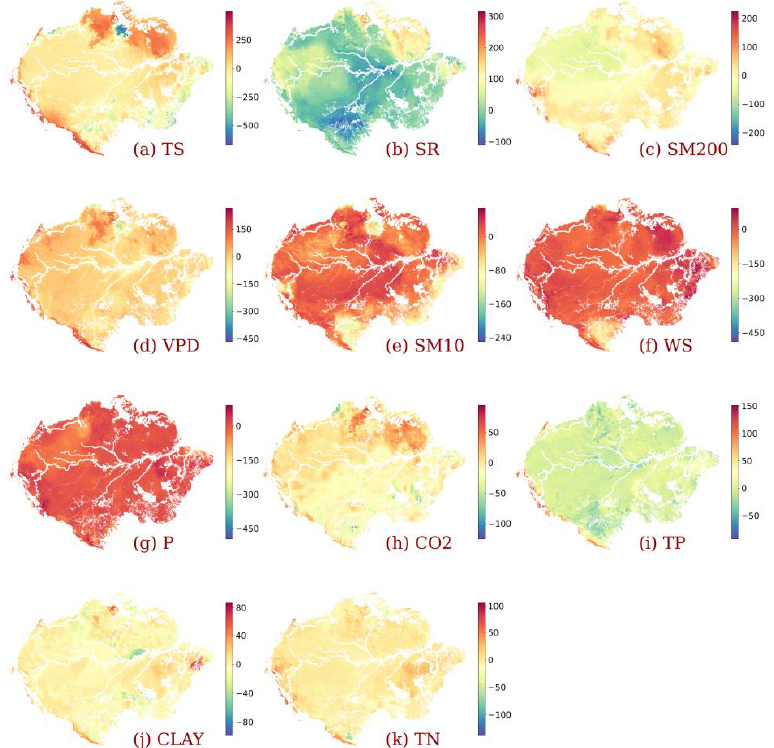
Figure 4. Spatial distribution of SHAP values for each 0.05° × 0.05° sample of ( a ) TS, ( b ) SR, ( c ) VPD, ( d ) SM200, ( e ) SM10, ( f ) WS, ( g ) CO 2 , ( h ) P, ( i ) CLAY, ( j ) TN, and ( k ) TP. Units of SHAP values: g C/m².